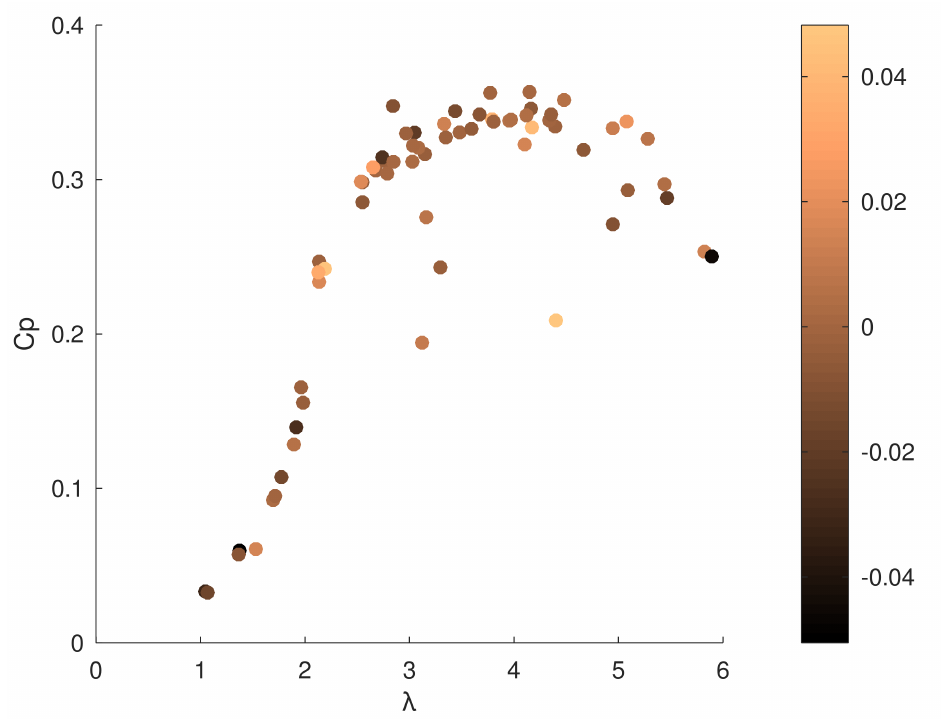
Figure 7. C p – λ data based on filtered steadiest 30 s samples from V1. Coloured by steadiness parameter α